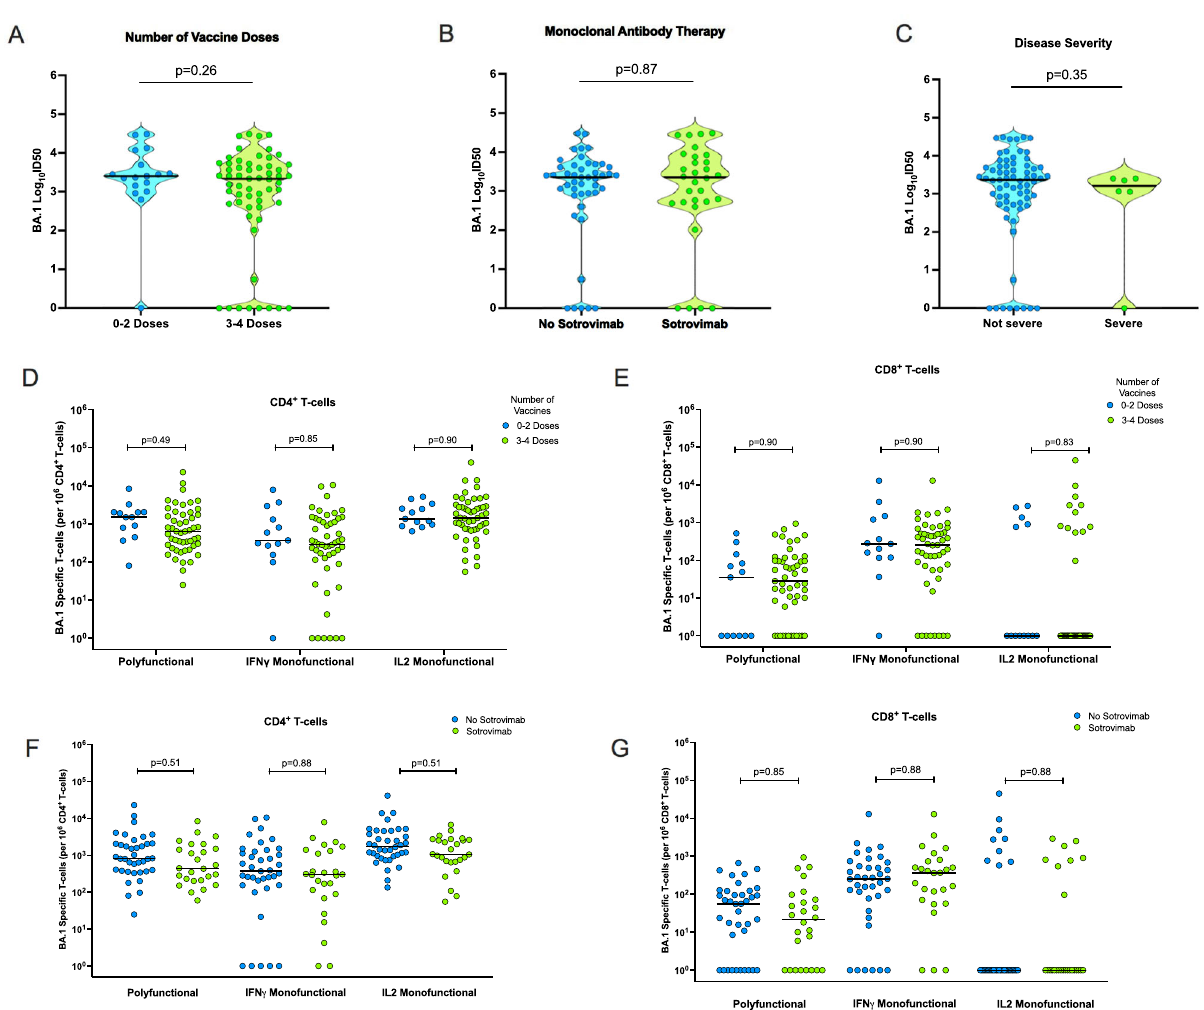
Fig. 5 | Comparison of the immune response to Omicron BA.1 in transplant patients with BA.1 infection by vaccination status, monoclonal antibody therapy,andseverityofdisease.A Violindotplotsofthe50%neutralizationtiters (log 10 ID50) of BA.1 speci fi c neutralizing antibodies in transplant recipients with Omicron-BA.1 infection, organized according to number of vaccine doses, 0 – 2 vs. 3 – 4; ( B ) use of monoclonal antibody therapy (sotrovimab); and C severity of dis- ease, de fi ned as requiring oxygen therapy. Horizontal lines represent median values. The p value of the difference between subgroups was estimated using